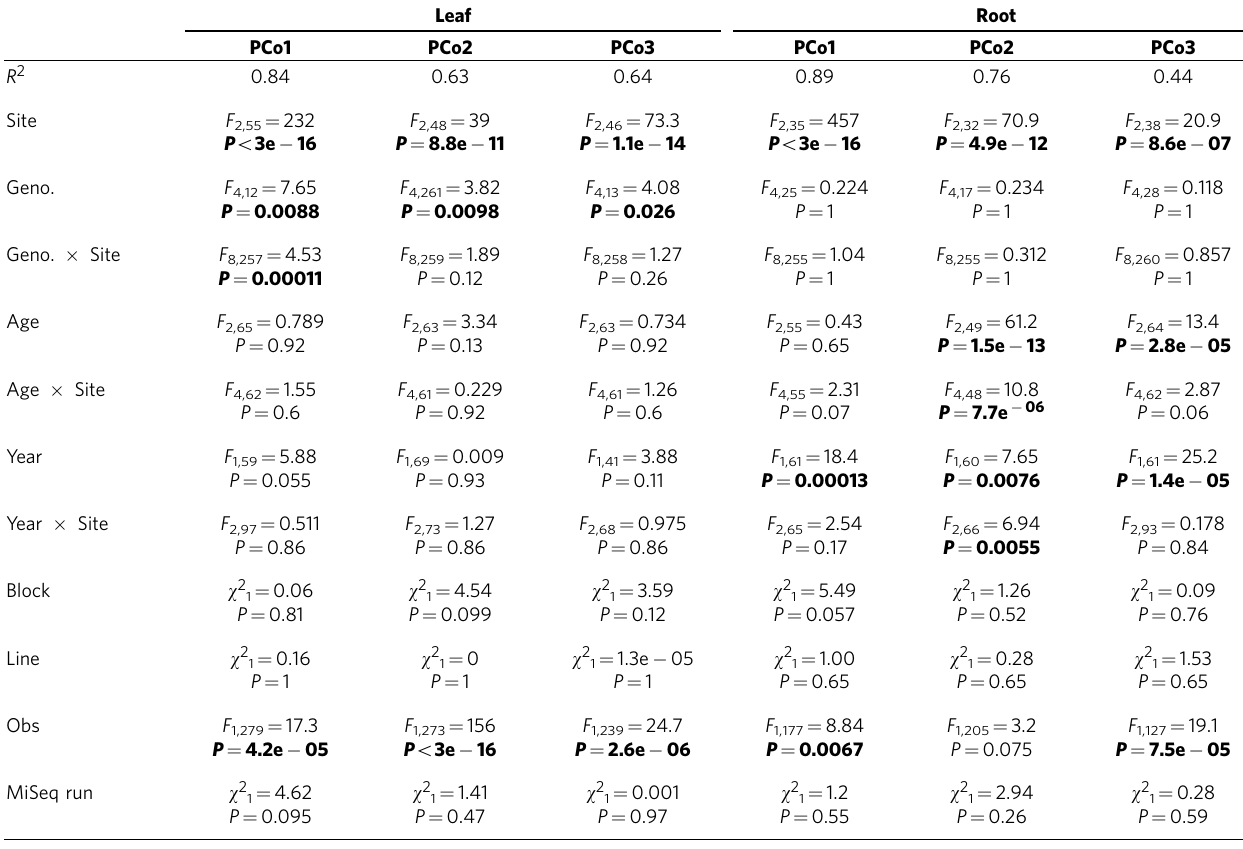
ANOVA, analysis of variance. Statistics describe linear random-intercept models of weighted UniFrac principal coordinates in leaves and roots. ‘Geno’, plant genotype; and ‘Obs’, total number of observations (log-transformed). All P values were adjusted for multiple comparisons using the sequential Bonferroni correction. Significance was assessed using type III ANOVA with F tests for fixed effects and likelihood ratio tests for random effects. Bold values indicate statistically significant results after correction for multiple comparisons, P o